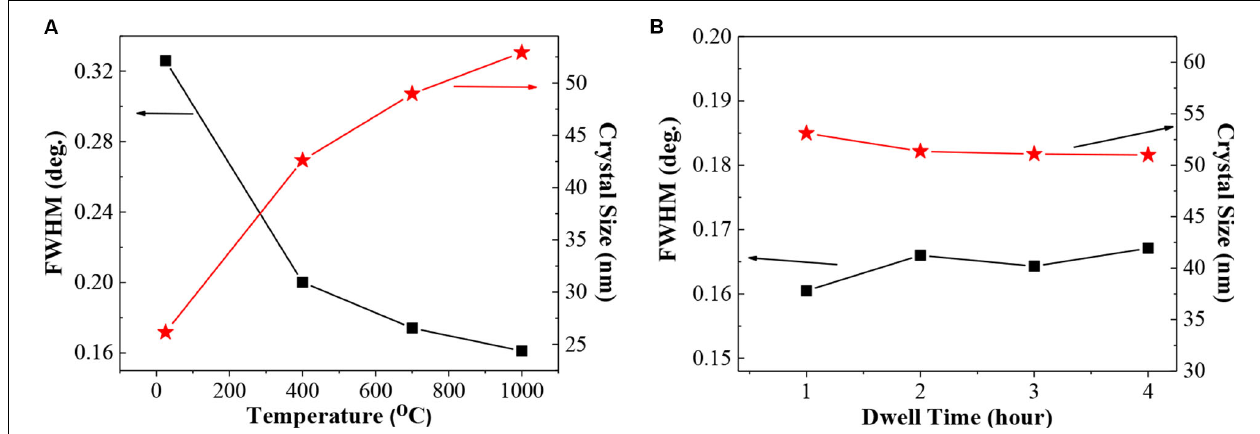
these ITO films remains almost stable for a long time (1–4 h). The results show that the crystalline state of ITO hardly changes as the dwell time increases, indicating that the microstructure of ITO is basically stable at 1,100 ◦ C and it will not affect the changes in the conductive properties.